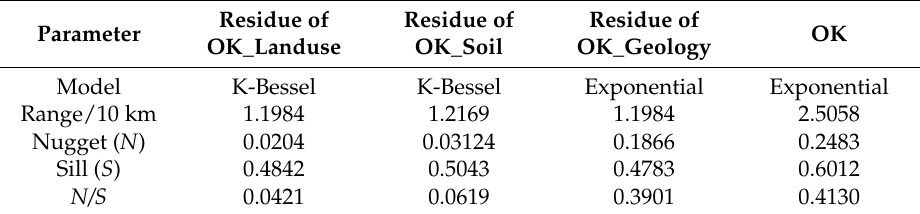
Table 2. Semi-variogram